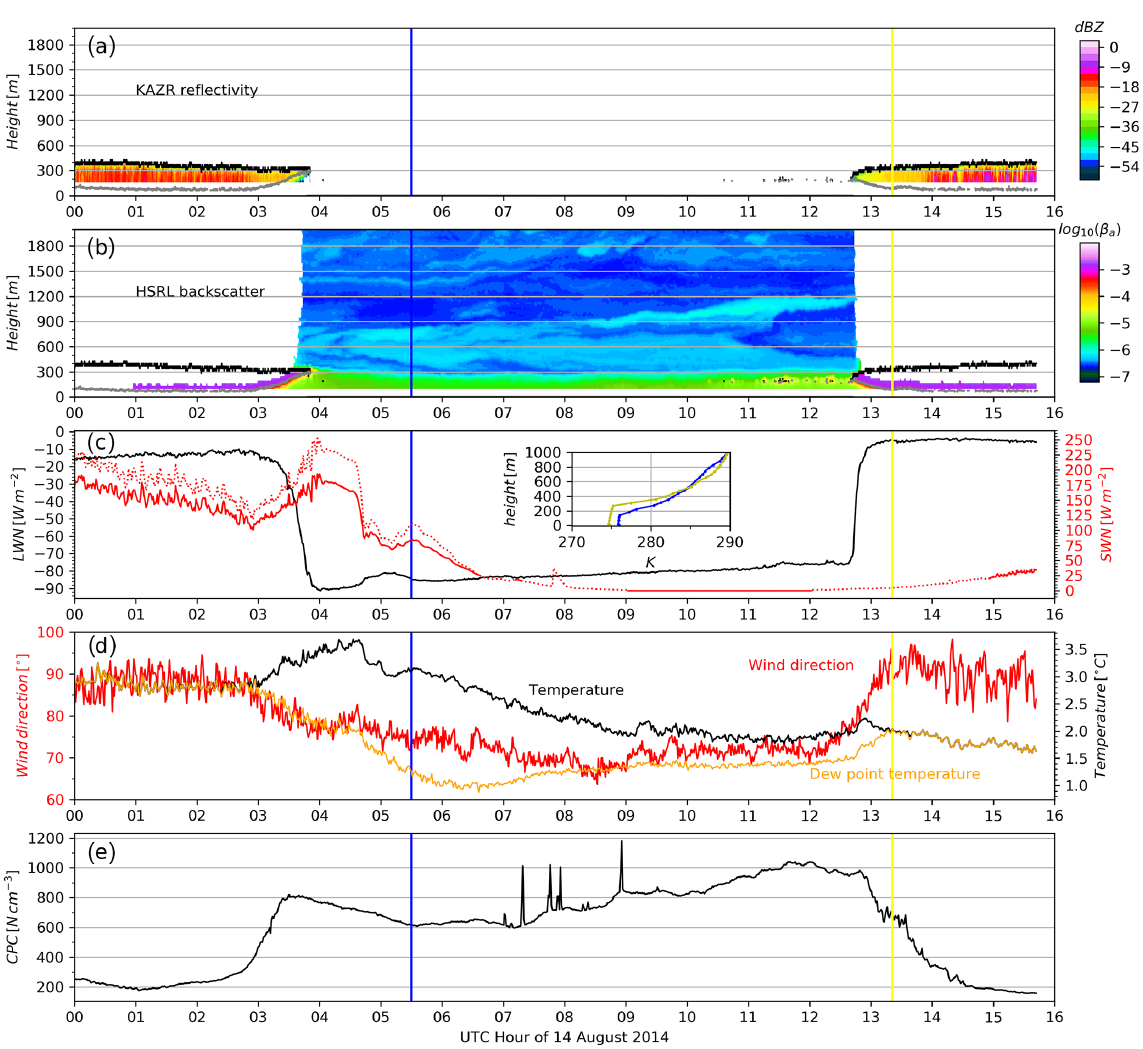
Figure 1. Temporal evolution [UTC] of cloud dissipation, a clear-sky period and the formation of a cloudy period from 14 August 2014 from the North Slope of Alaska. (a) KAZR reflectivity [dBZ, contours] and cloud top (black) and base height (gray) boundaries. (b) HSRL backscatter [log 10 ( Ba ) ] including cloud top and base boundaries. (c) Net longwave (black) and net shortwave (red) radiation, including downwelling shortwave (dashed red), all in Wm − 2 ; the inset includes equivalent potential temperature [K] profiles from radiosoundings at 05:30 (blue) and 13:15UTC (yellow); the vertical blue and yellow lines in each panel represent the radiosounding launch time. (d) Near- surface wind direction [degrees, red], temperature [K, black] and dew point temperature [K, orange]. (e) Near-surface particle concentration [Ncm 3